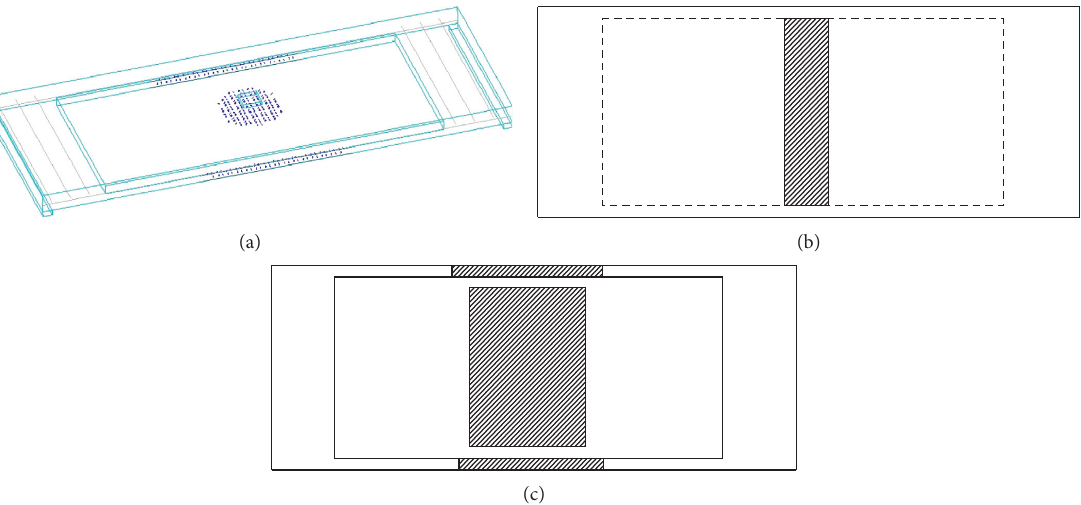
Figure 13: The main fracture regions of the FEM. (a) Fracture development model. (b) Top fracture development area. (c) Bottom fracture development